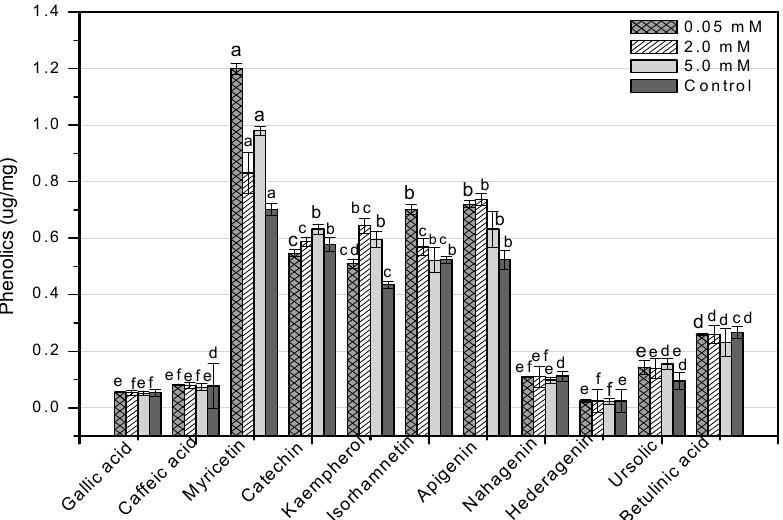
Figure 13. HPLC-based quantification of phenolic compounds in F. indica calli elicited with seven different concentrations of aluminum chloride along with control. Mean values with standard errors (± SE) and bars labeled with different letters (LSD values) exhibit significant variation ( α < 0.05).